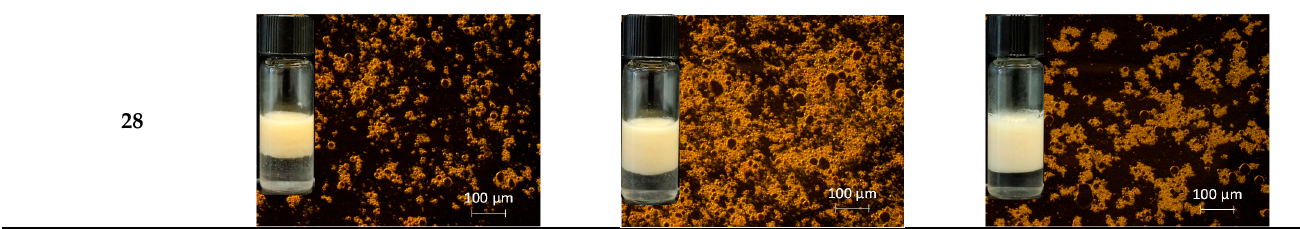
Figure 7. Fluorescence microscopy and visual images of emulsions stabilized by cellulose and tomato pomace subjected to different mechanical treatments over 28 d of storage, at 4 °C, at different pH values.